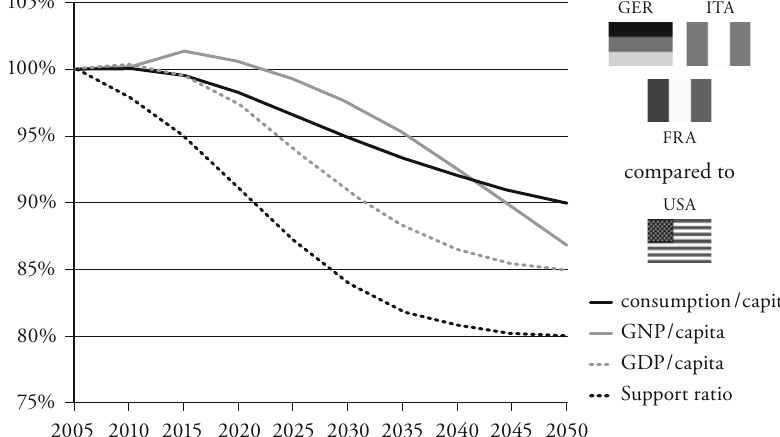
Figure 3: Endogenous adaptation mechanisms: support ratio, GDP, GNP and consumption per capita (international diversification: 2005 (cid:2)(cid:3) 100%,